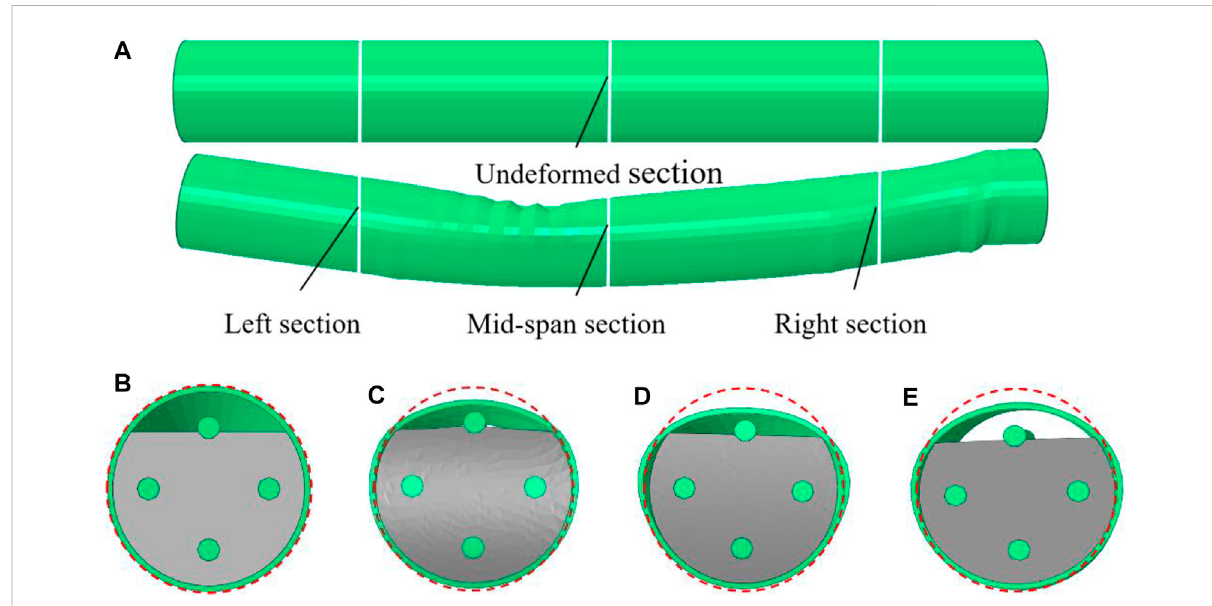
FIGURE 10 Damageformofthepiperoofwithreinforcementbundlesat20%groutingincompleteness (A) Beforeandafterdeformationofthepiperoof (B) Undeformed section (C) Left section (D) Mid-span section; and (E) Right section.